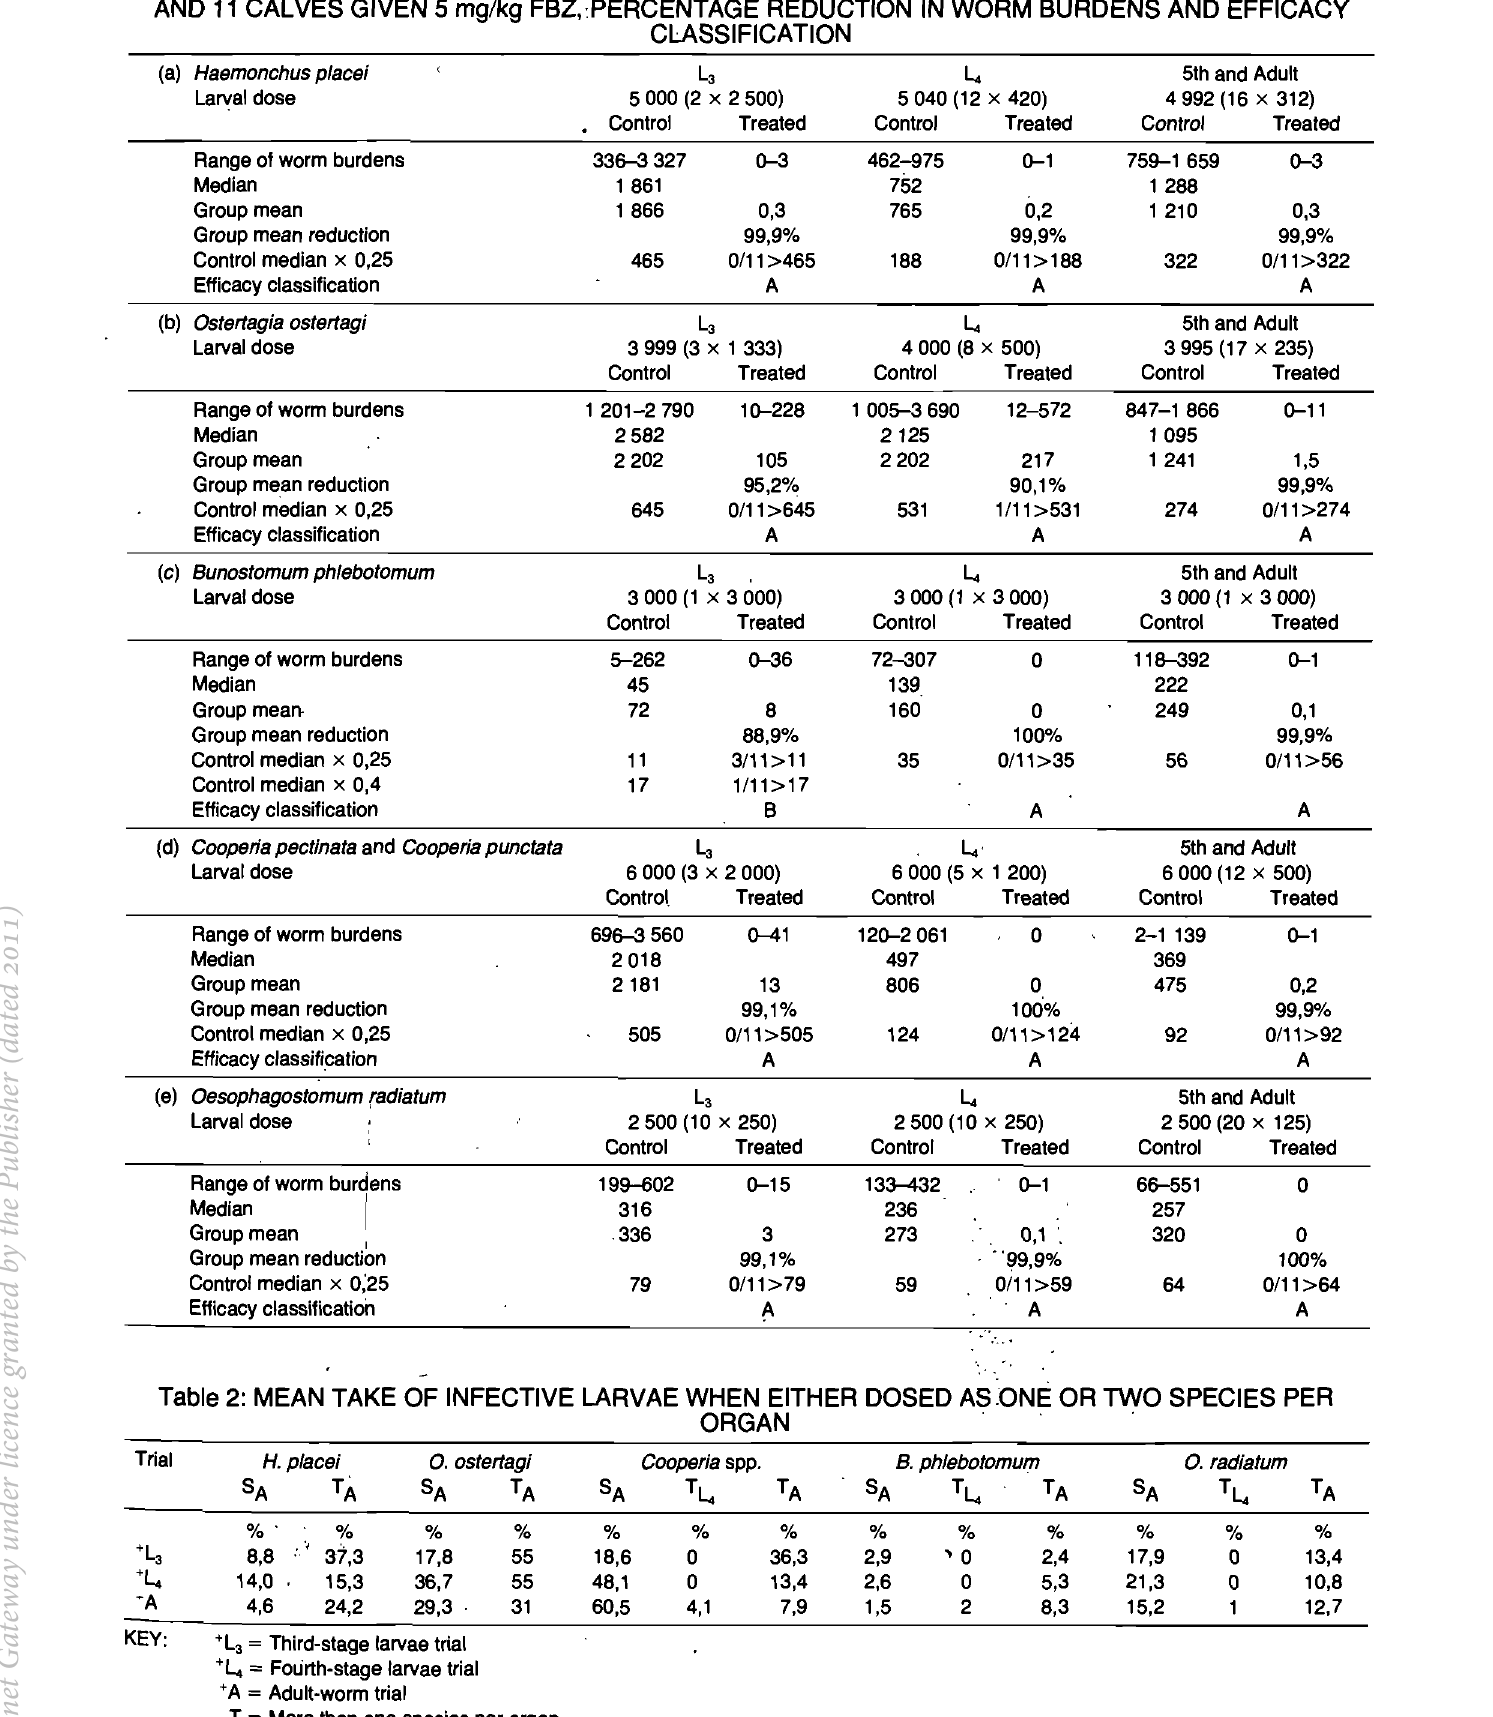
Table 2: MEAN TAKE OF INFECTIVE LARVAE WHEN EITHER DOSED AS.ONE OR TWO SPECIES PER Trial Hoplacei O.